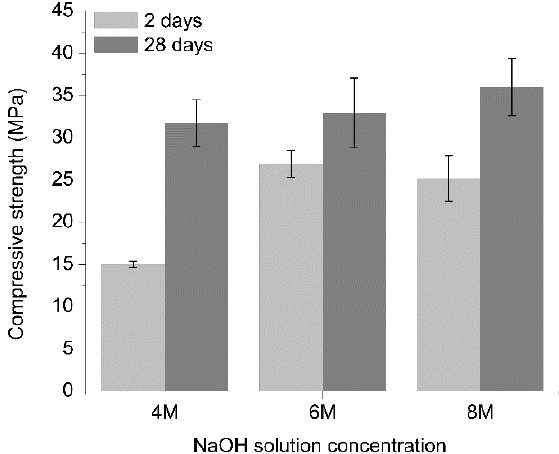
Figure 2. Two and 28 days compressive strength in 4, 6 and 8 M NaOH-activated pastes (six specimens per test age and material were tested).